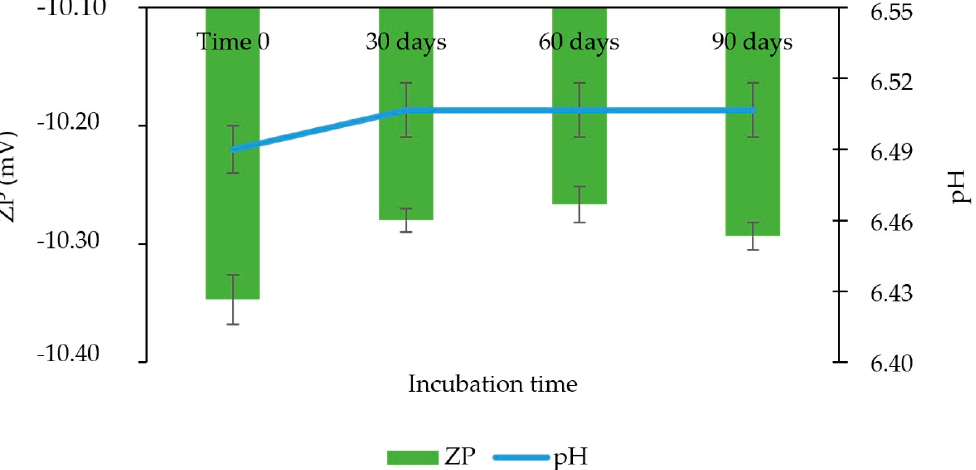
Figure 10. Determination of zeta potential (ZP) and pH for the accelerated stability study of the nanosuspension of besifloxacin 0.6 wt%, in the time intervals: T0, 30, 60, and 90 days. Study condition: 40 °C ± 2 °C/75% RH ± 5% RH. n = 3 batch.